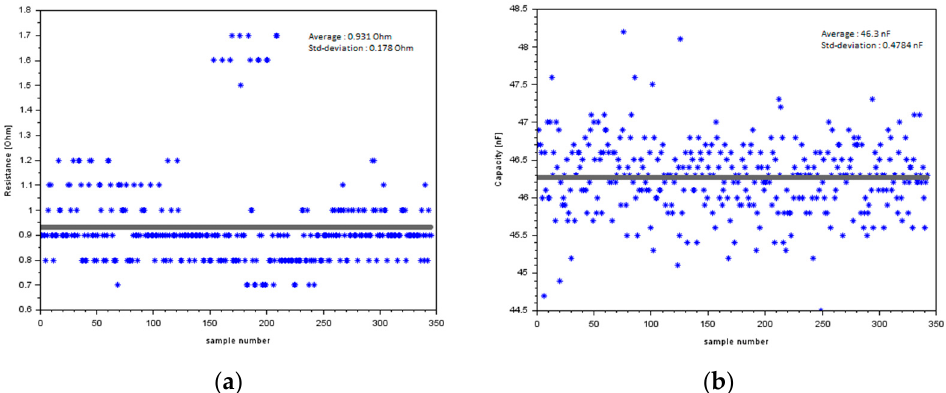
Figure 9. Electrical test results of the daisy chain packages; ( a ) daisy chain resistance of chip to package interconnects, ( b ) capacity of integrated capacitors.